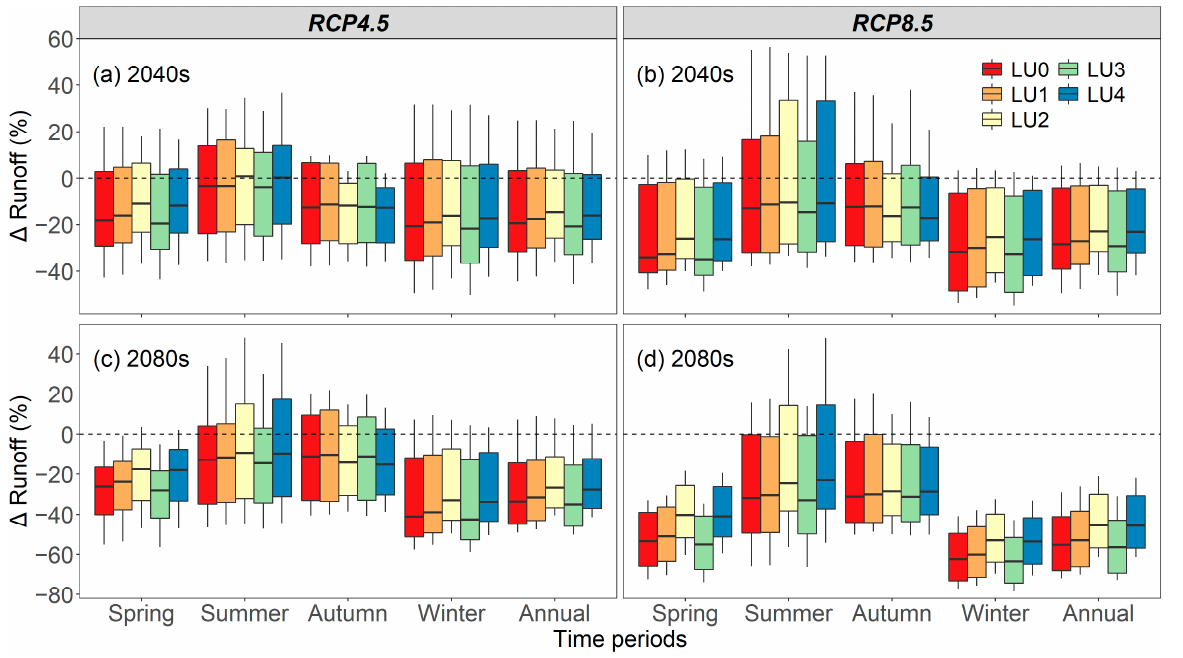
Figure 7. Projected seasonal and annual changes in runoff (%) for LU0 − LU4 in the 2040s and 2080s under both RCPs estimated from 34 GCMs compared to the baseline period. Data displayed are changes in the 40 − year averages for each of the 34 GCMs. The lower and upper whiskers show the 10th and 90th percentiles; box boundaries show the 25th and 75th percentiles; the black line within each box marks the median values.